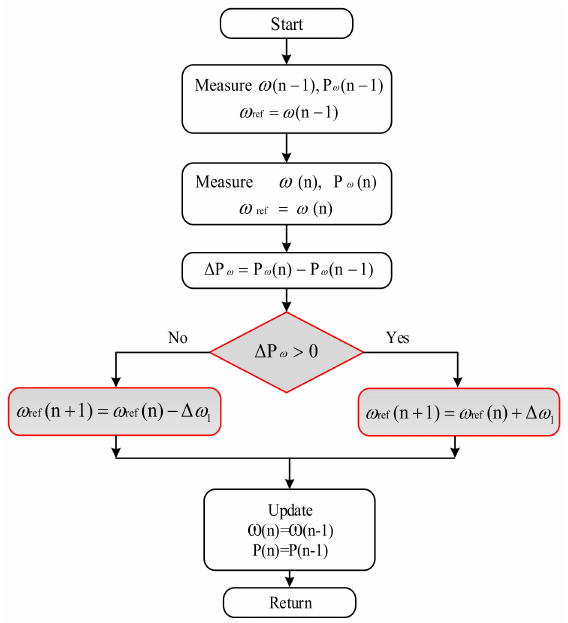
Figure 8. Flowchart of proposed AD-HCS